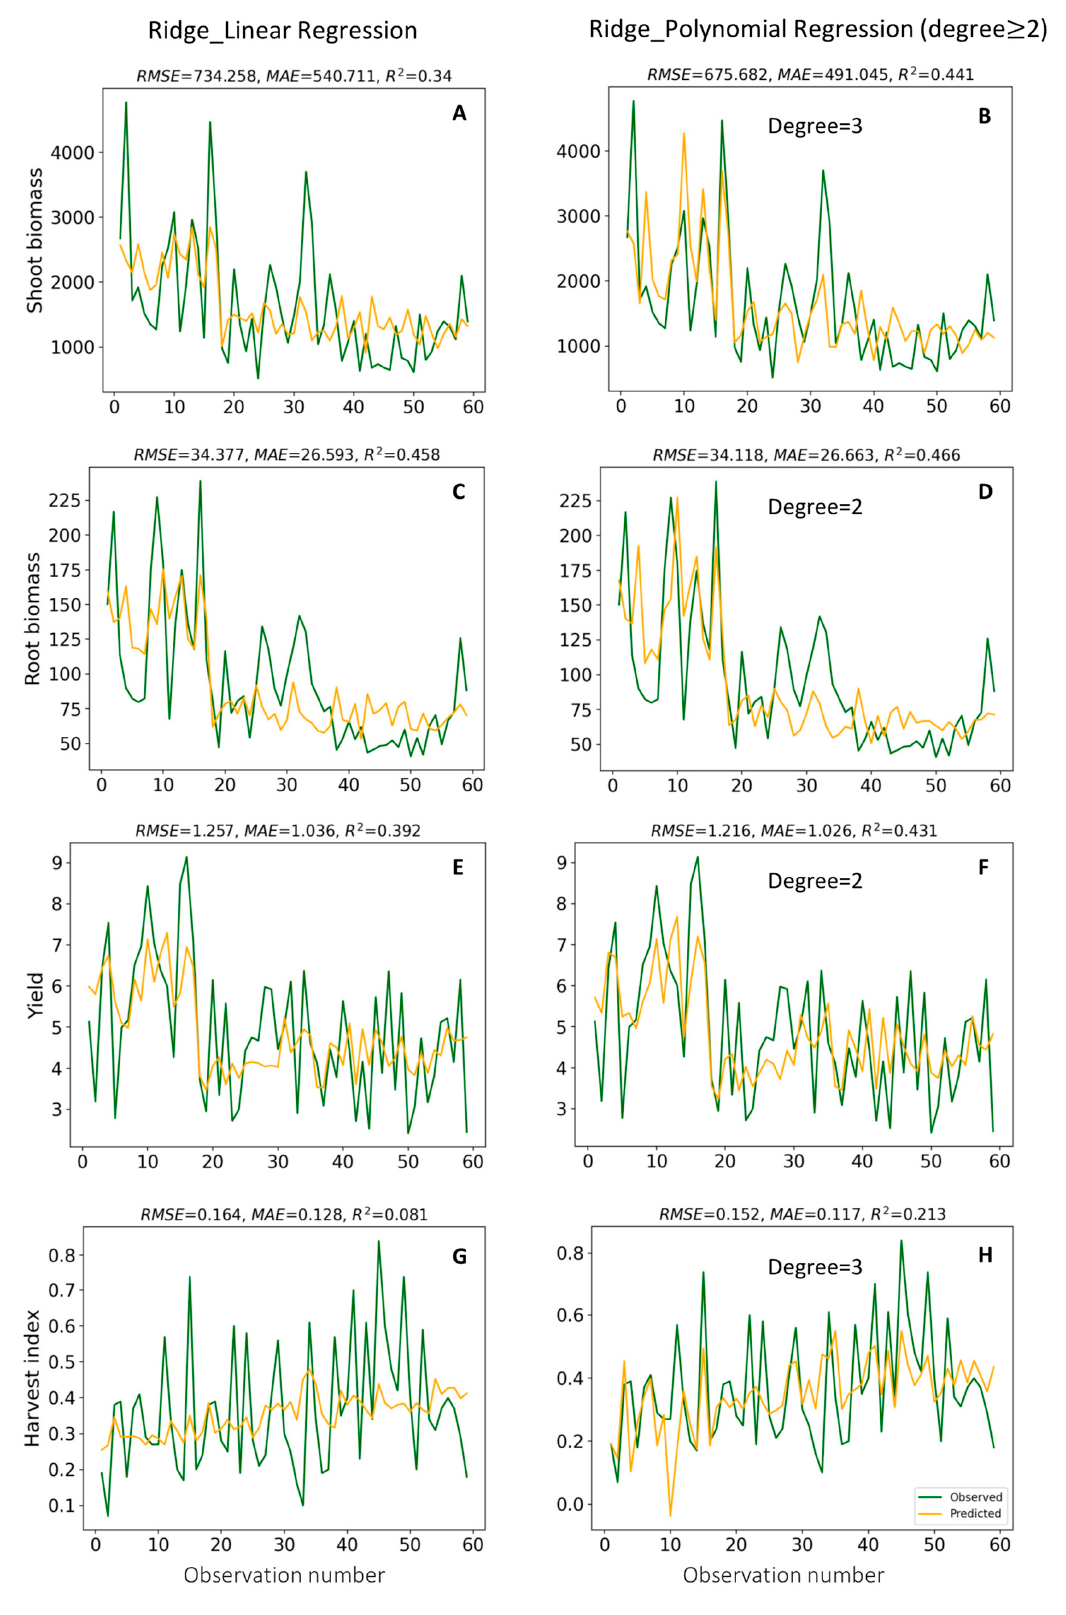
Figure 8. Predicted vs. observed plant growth indicators (( A , B ) shoot biomass, ( C , D ) root biomass, ( E , F ) grain yield, ( G , H ) harvest index) by ridge linear regression ( A , C , E , G ) and exponential polynomial regression ( B , D , F , H ). The degree represents the number of exponent.